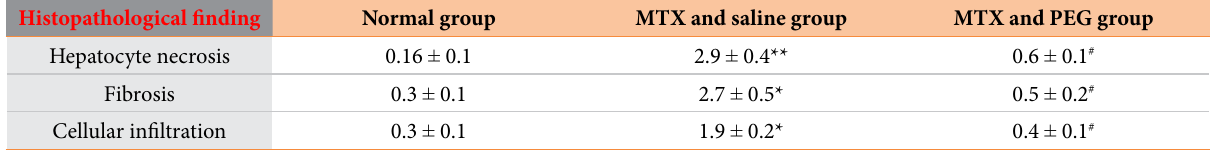
Figure 1 - Liver histolopathology haematoxylin and eosin (20× and 40× magnification). ( a and b ) Normal liver, central vein (CV) and portal vein (PV); ( c and d ) methotrexate and saline groups have bridging necrosis, fibrosis and cellular infiltration in portal area (PV) ( arrow ); ( e and f ): methotrexate and polyethylene glycol groups have decreased bridging necrosis fibrosis and cellular infiltration in portal area (PV) ( arrow ). Table 2 - Comparison of histopathological findings between subject groups $